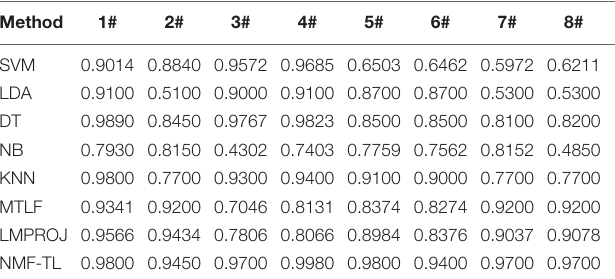
TABLE 11 | Recall of 8 classifiers on datasets based on PCA feature extraction.